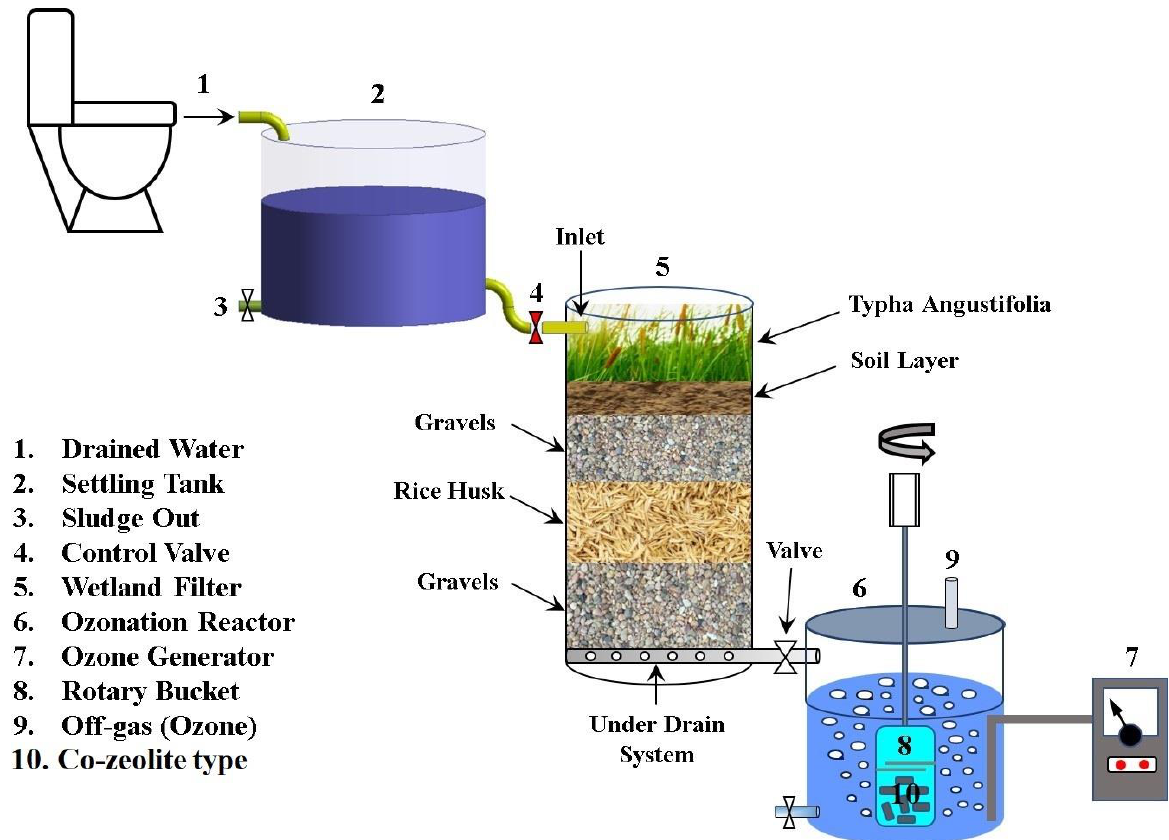
Figure 1. Experimental Setup.